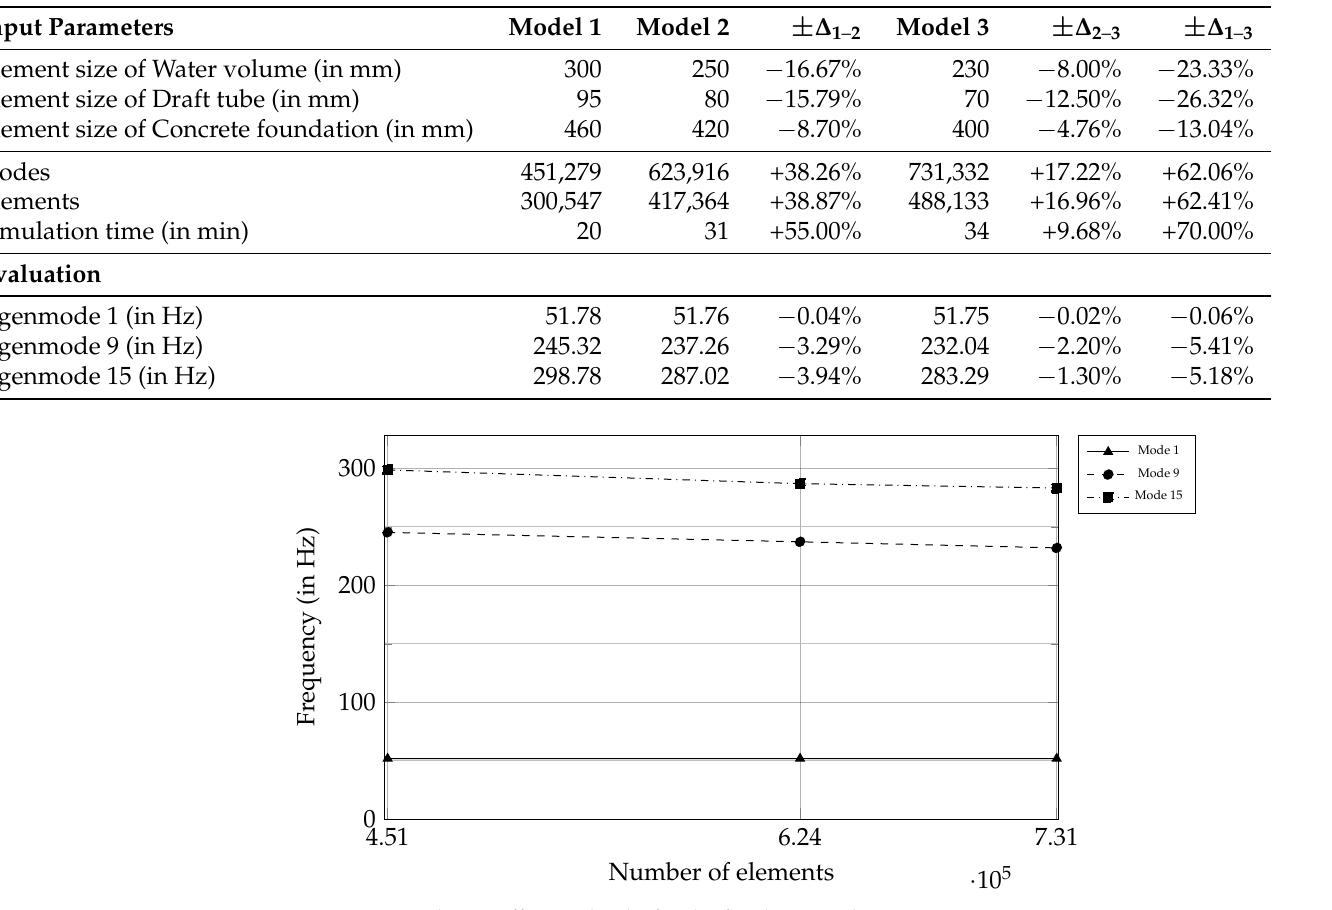
Figure 15. Mesh size effect at the draft tube for three